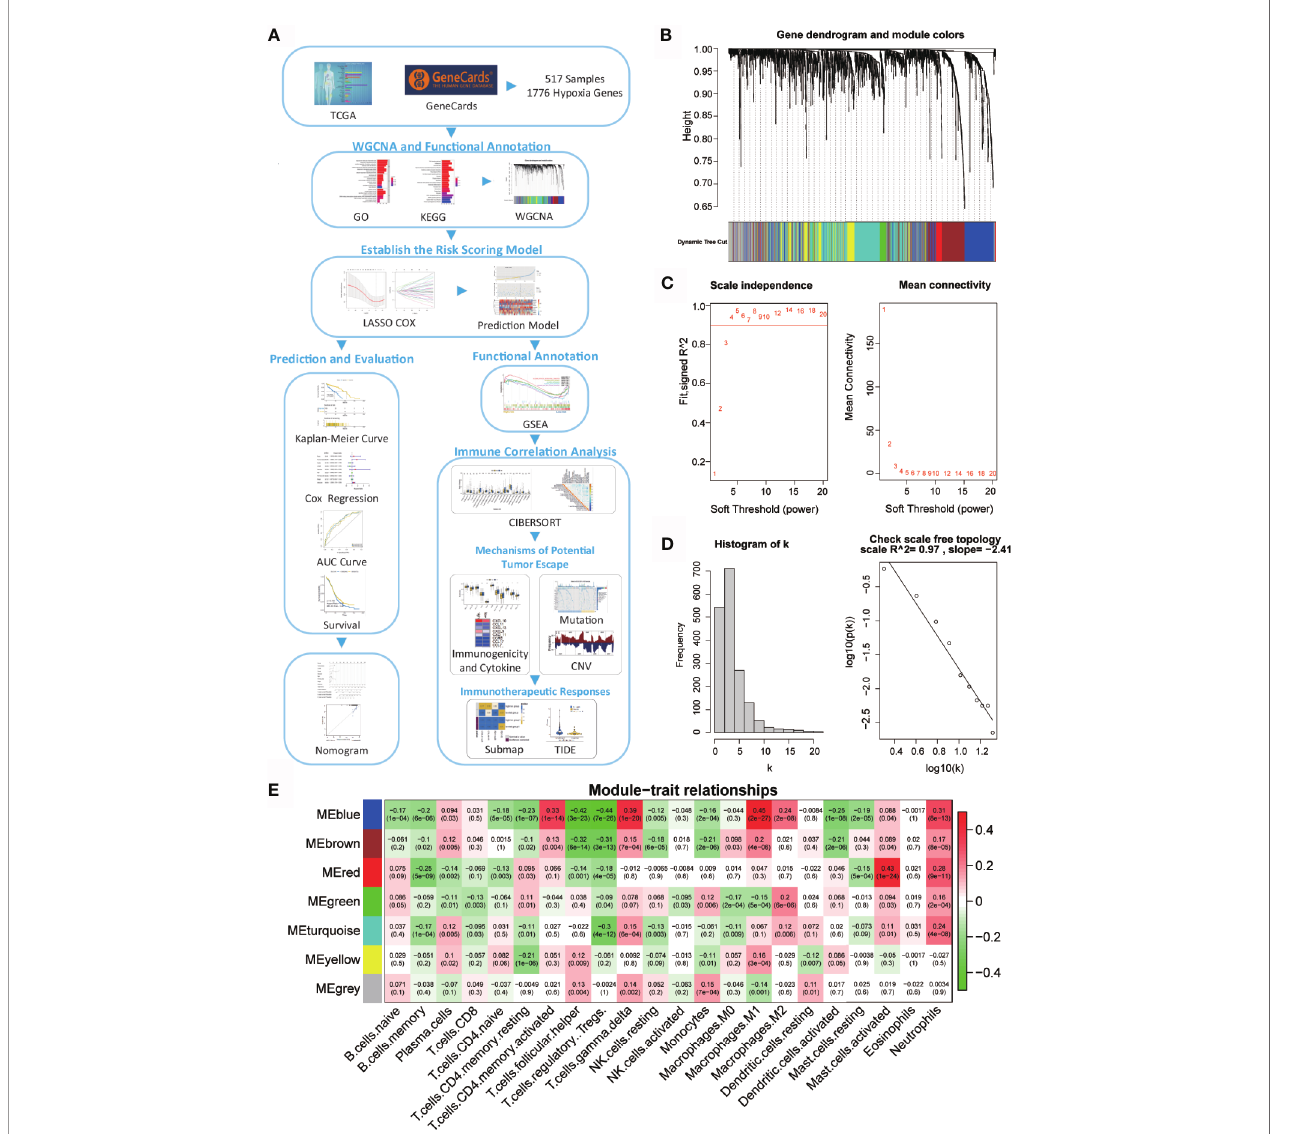
FIGURE 1 | Network of co-expressed genes and module – trait relationships. (A) Flow diagram of this study ’ s systematic analysis and validation. (B) Dendrogram of the differentially expressed genes clustered based on different metrics. Each branch in the fi gure represents one gene; each color indicates a single module that contains weighted co-expressed genes. (C) The left panel presents the relationship between the soft-threshold and scale-free R2. The right panel presents the relationship between the soft-threshold and mean connectivity. (D) Veri fi cation of the scale-free network. (E) Heatmap of the correlation between the module eigengenes and the immune cells in ovarian cancer. Each column contains the corresponding correlation and p